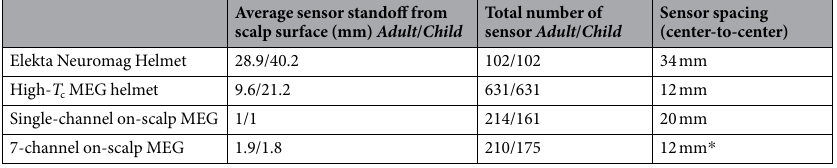
Table 2. Geometric parameters for sensor array layouts. * Sensor spacing within a single cryostat. Inter-cryostat spacing was 54